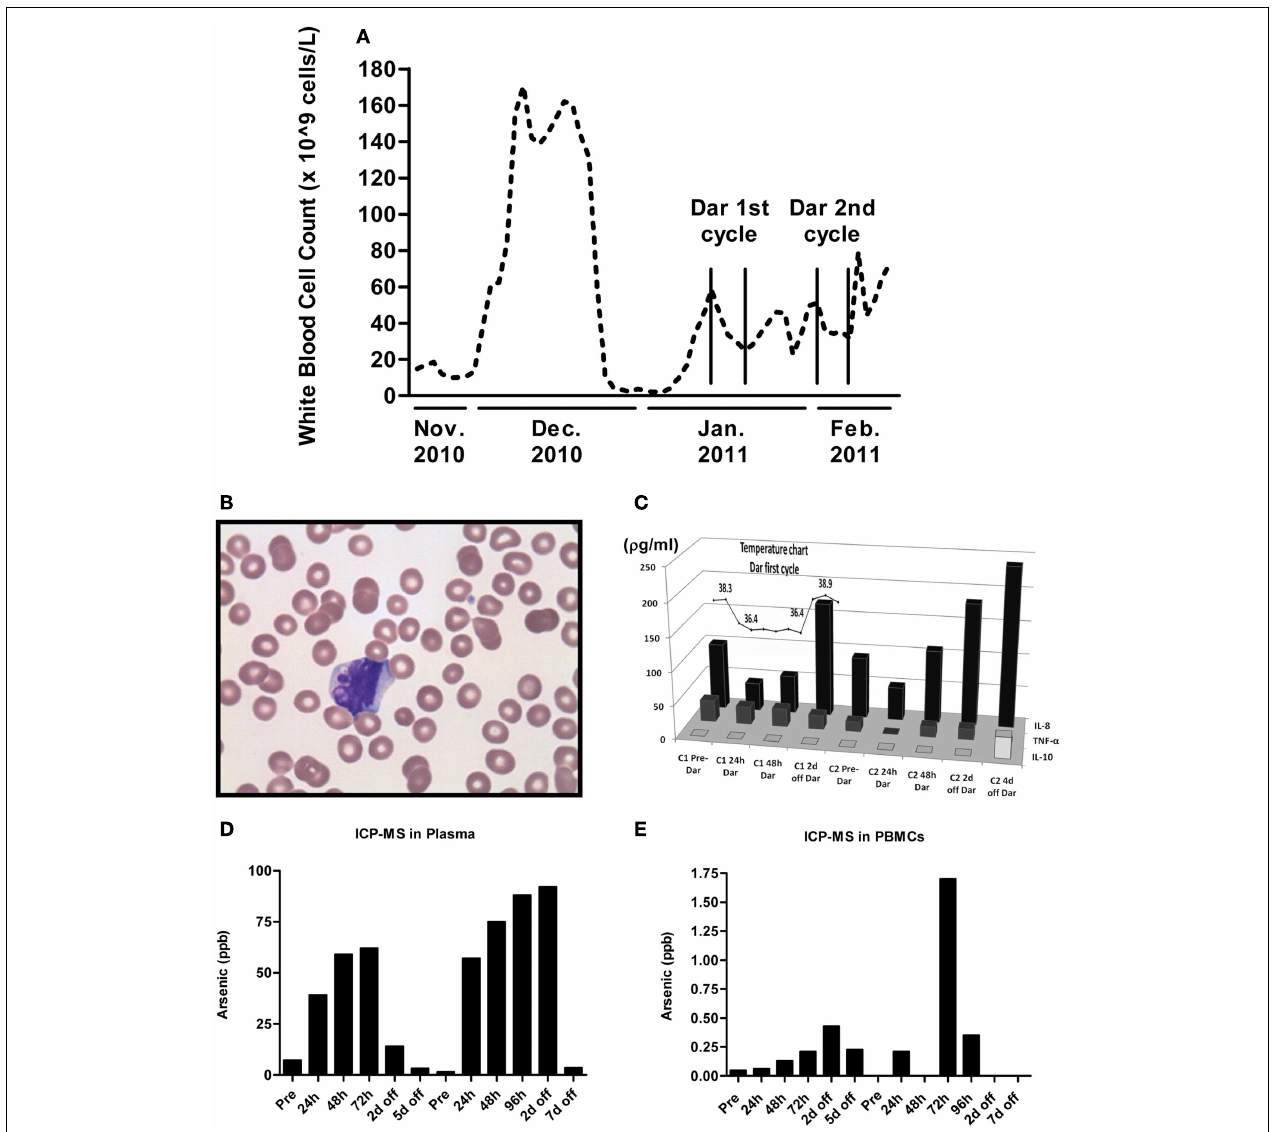
factor-alpha. Samples taken prior to starting treatment with darinaparsin are labeled “Pre” while time points during and after darinaparsin treatment are labeled with cycle number (C1, cycle 1; h, hours; d, days) and time on or off darinaparsin treatment.The patient was allowed to go home 3days after completing her first course of darinaparsin. Elemental arsenic levels were measured in patient plasma (D) and peripheral blood mononuclear cells (PBMCs) (E) by inductively coupled plasma mass spectrometry.The highest plasma level of arsenic measured with this dosing schedule was approximately 90 parts per billion (ppb). Given arsenic’s molar mass of 75g/mol, this is equal to a plasma concentration of 1.2 µ M, which corresponds well with the doses used for ex vivo experiments in Figures 1C,D